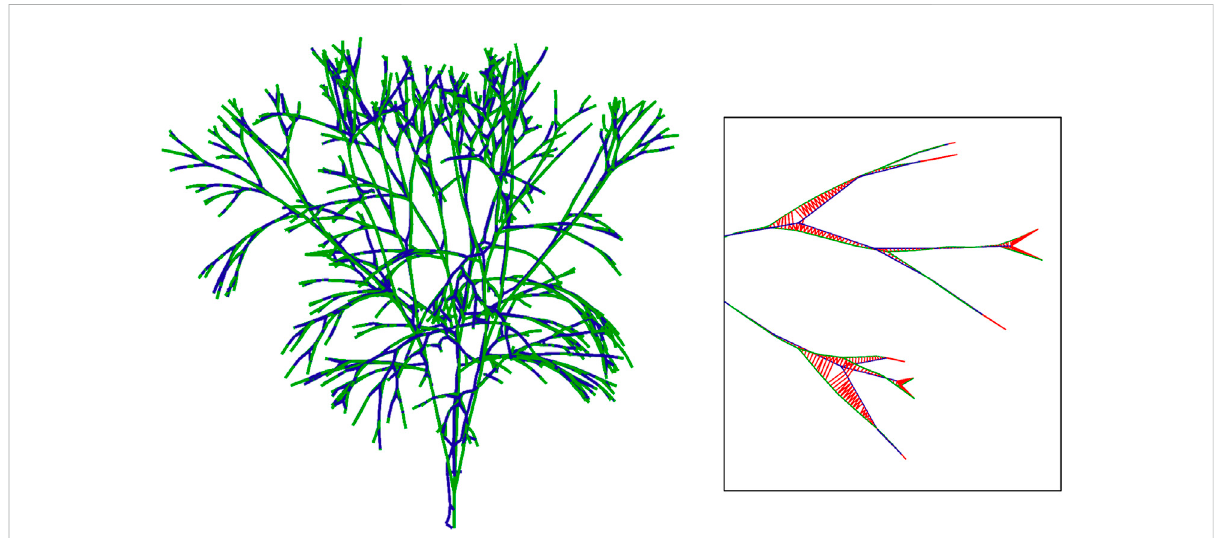
FIGURE 5 Comparisonbetweentheground-truthskeleton(green)andourreconstructedskeleton(blue).Thedistancebetweenthetwoskeletonsisused as a quantitative evaluation of our